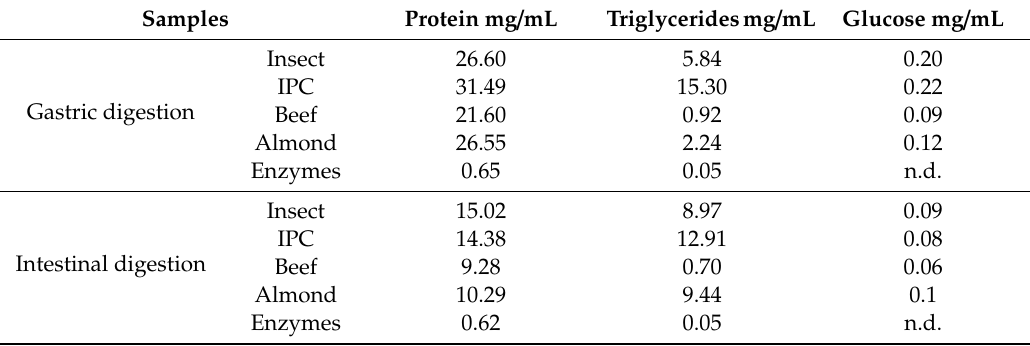
a b Figure 1. Protein hydrolysis of food after gastric ( a ) and intestinal ( b ) digestion. Samples marked with “ + ” are the digested ones and the samples marked with “ − ” are the negative controls for each digestion. The protein load was adjusted to 30 µ g of protein in each lane, except for the enzyme controls, which were used without dilution. A molecular weight marker (10–180 kDa) was included. I, insect; IPC, insect powder concentrate; B, beef; A, almond; Eg, gastric enzyme control; Ei, intestinal enzyme control; M, molecular weight marker. Table 1. Protein, glucose, and triglyceride composition of digested food samples after gastric and intestinal in vitro